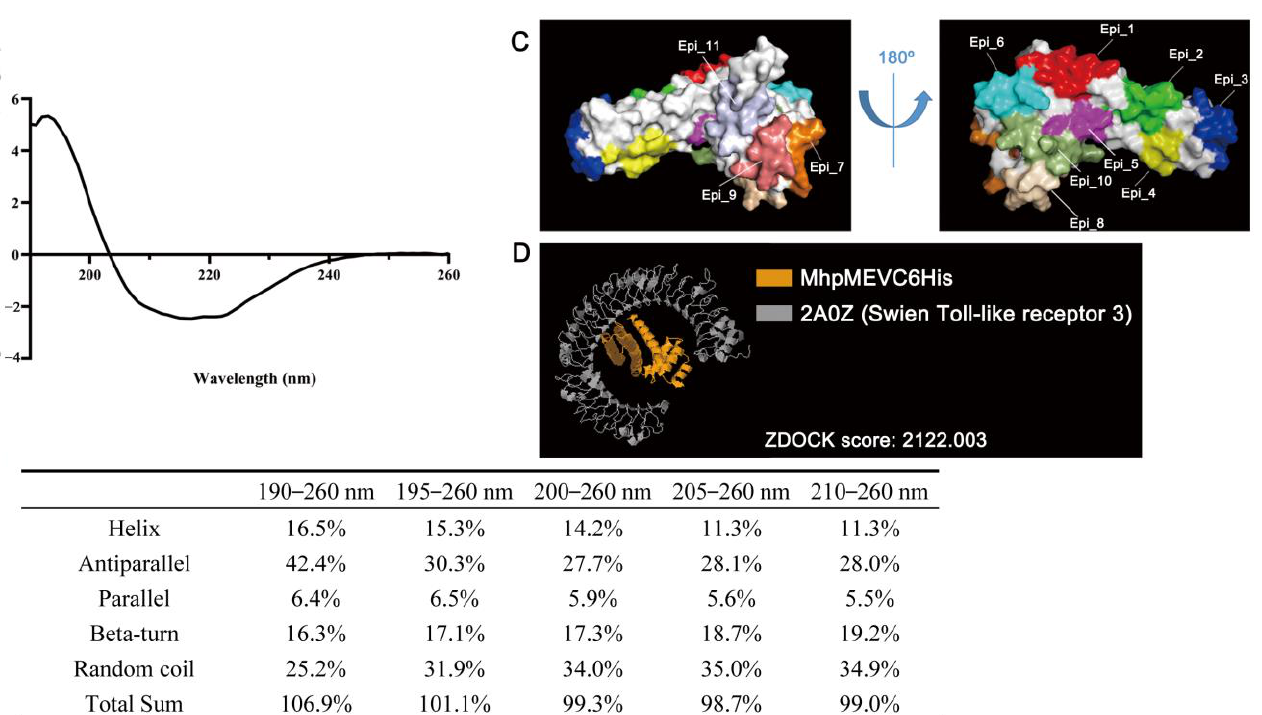
Figure 5. Structure analysis and molecular docking of MhpMEVC6His ( A ) The far-UV circular dichroism spectra of MhpMEVC6His. ( B ) The ratio of different secondary structures calculated by CDNN in MhpMEVC6His. ( C ) The three-dimensional structure model of MhpMEVC6His was predicted by Robetta and the 11 epitopes are colored and demonstrated. ( D ) Molecular docking result of MhpMEVC6His and swine Toll-like receptor 3; this model presented the best binding conformation with the highest ZDOCK score.